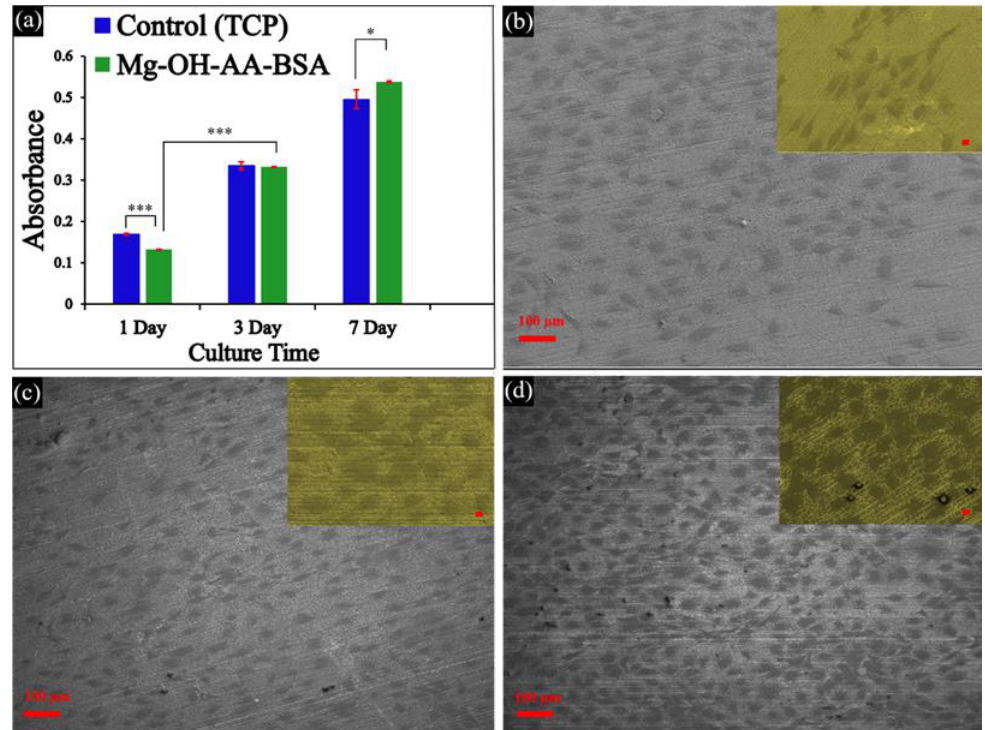
Figure 9. ( a ) Pre-osteoblast cell viability (cell counting Kit-8, CCK8 test) on the Mg-OH-AA–BSA (samples) and TCP (as control). ( b–d ), Representative SEM images of MC3T3-E1 cells cultured on Mg-OH-AA-BSA scaffolds surface after (1, 3, and 5) days of culture. Data presented as mean ± SD, and analyzed using ANOVA, * p ˂ 0.05, and *** p < 0.001 (Scale bar =20 µm (insets)).